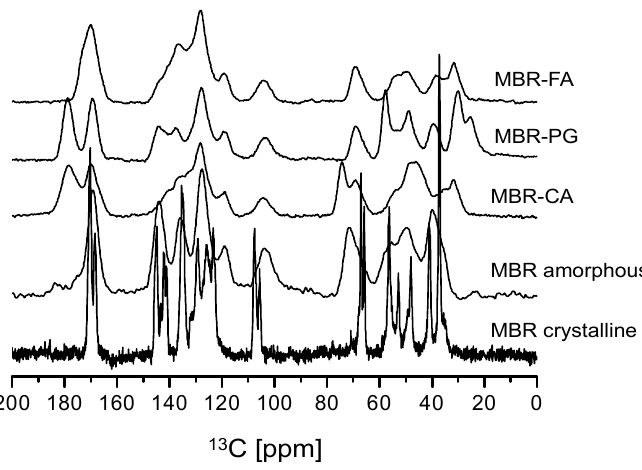
Figure 5. Solid-state CP/MAS 13 C-NMR spectra of MBR co-amorphouses (MBR-FA, MBR-PG, and MBR-CA), MBR amorphous and MBR crystalline solid.